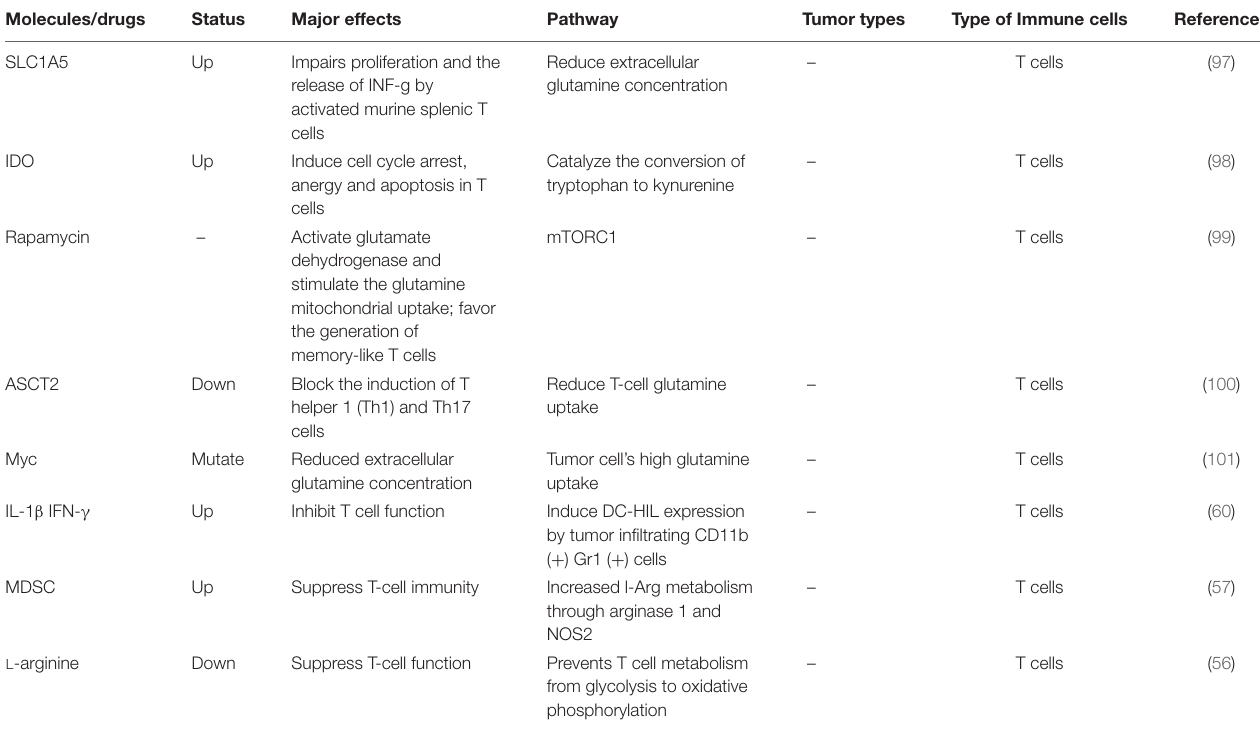
TABLE 3 | Amino acid metabolism and tumor immunity.